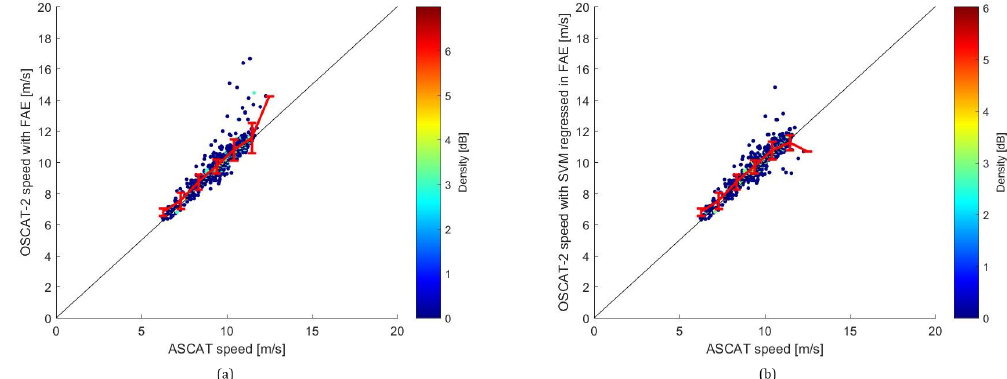
Figure 8. The FAE wind speed (a) and the corrected ones (b) against ASCAT wind speed in the data set of Fig.